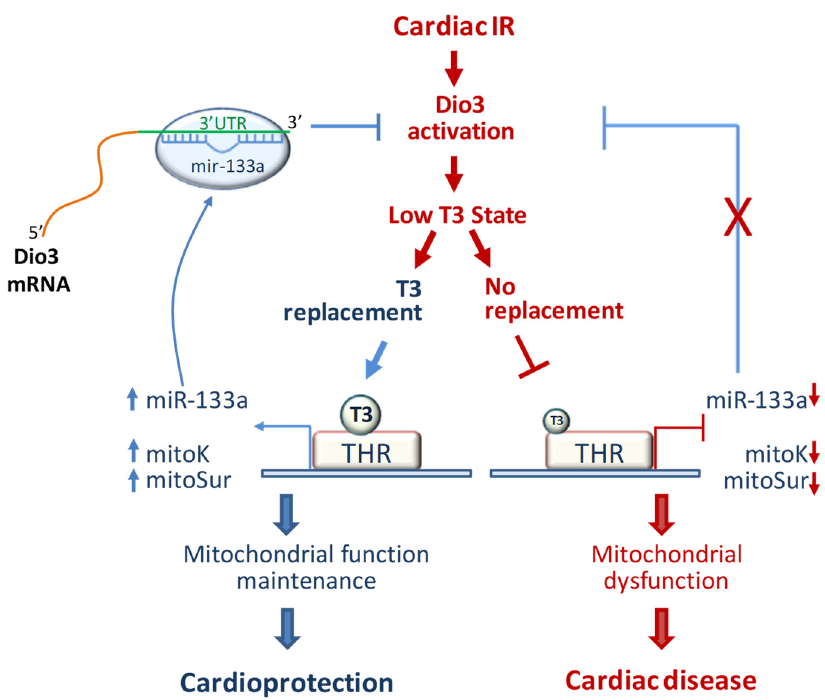
Figure 7. Schematic summary of the action of T3 through the miR-133a-Dio3 axis in the post-IR myocardium. Adverse pathways induced by ischemic stress and cardiac reperfusion are shown in red, whereas the cardioprotective pathways activated by the exogenous administration of T3 are represented in blue. THR = thyroid hormone receptor.